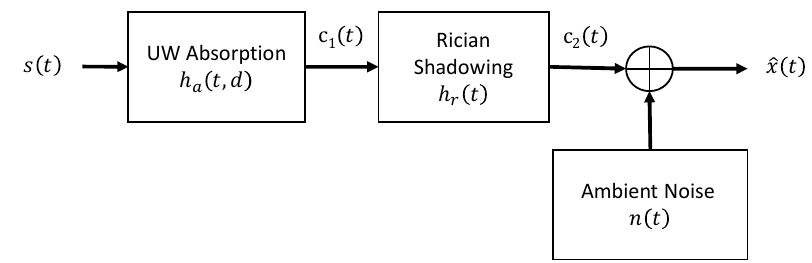
Figure 5. Shallow underwater acoustic channel